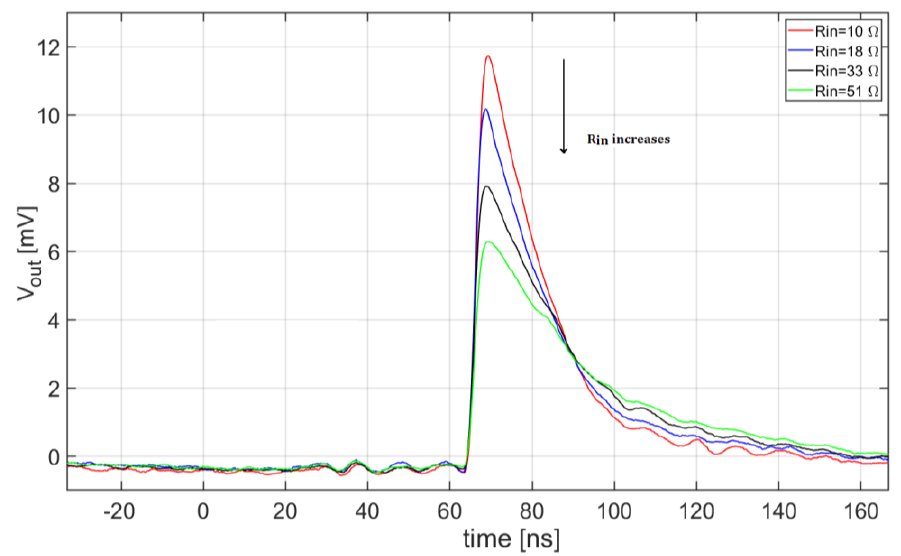
Figure 14. Examples of ‘golden’ pulse waveforms, obtained with L = 51 nH and different values of R in .